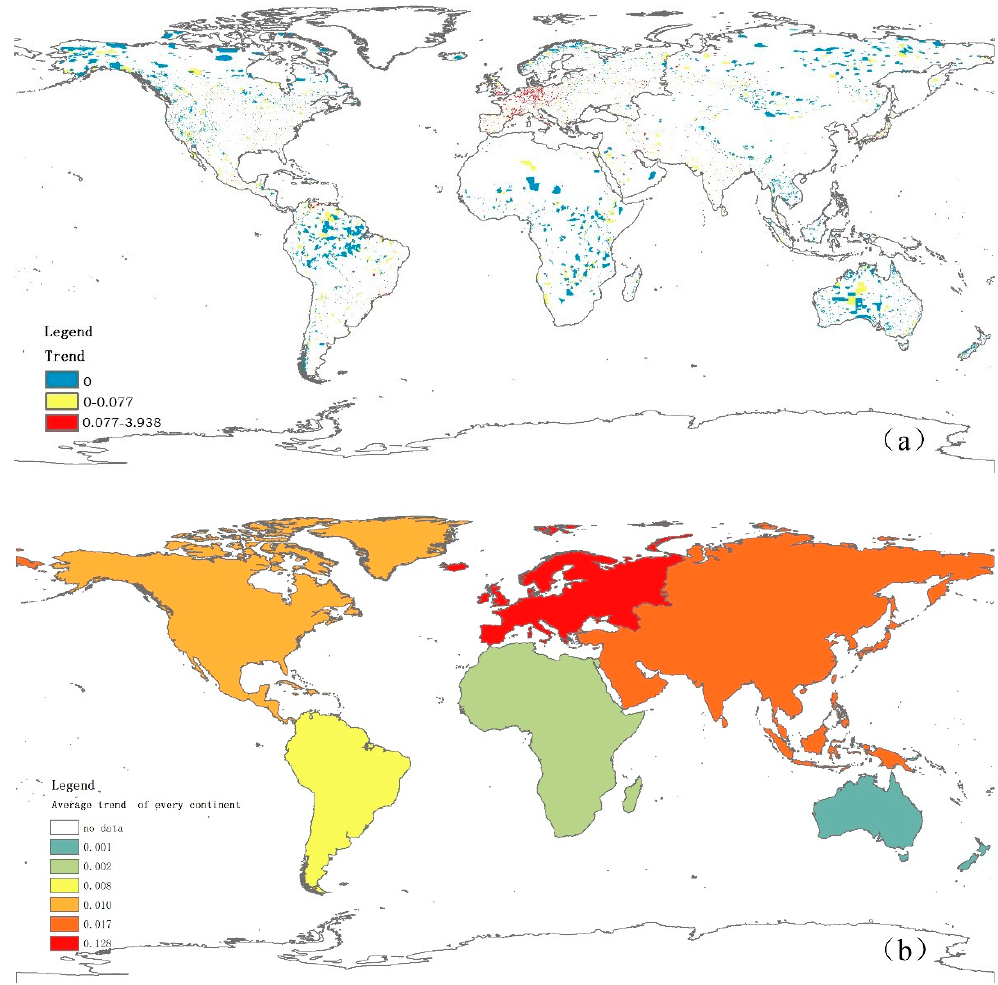
Figure 5. ( a ) Average trend of NTL of the global terrestrial PAs and ( b ) average trend of every continent. For ( a ), we used the natural breaks (Jens) method to divide the PAs into three levels according to the average trend of NTL. The blue-colored PAs had an average trend of 0, the yellow-colored PAs had a lower than average trend, and the red-colored PAs had a higher than average trend. For ( b ), the ranking of the average NTL trend of PAs in each continent gave the order as Europe > Asia > North America > South America > Africa > Oceania.